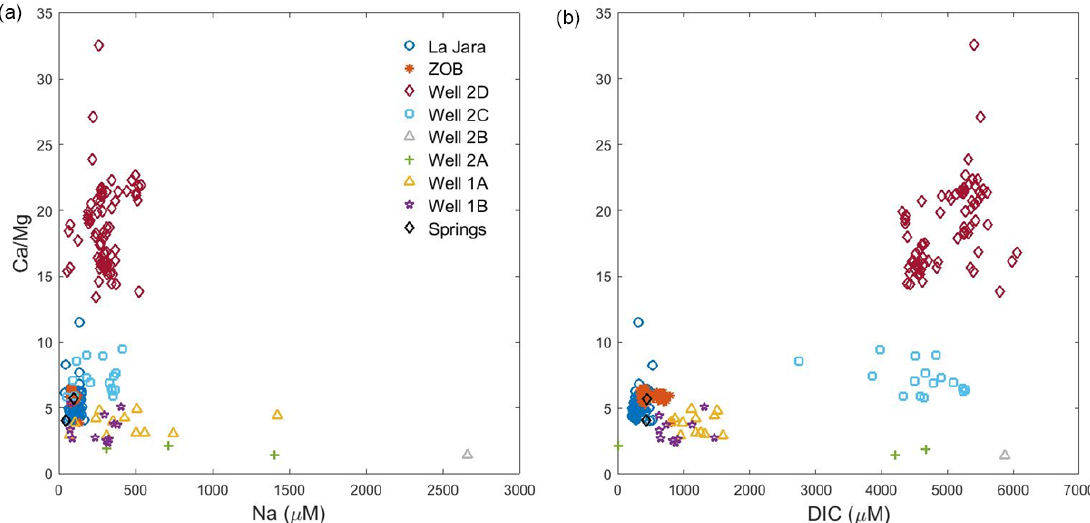
Figure 8. (a) Ca 2 + / Mg 2 + molar ratios compared to Na + concentrations show that groundwater from well 2D has Ca 2 + / Mg 2 + ratios that are chemically distinct from the other water stores, which suggests that deeper groundwater is more representative of streamflow than shallow groundwater. (b) Ca 2 + / Mg 2 + ratios compared to DIC concentrations show that site 1 groundwaters are more representative of the contribution to streamflow.